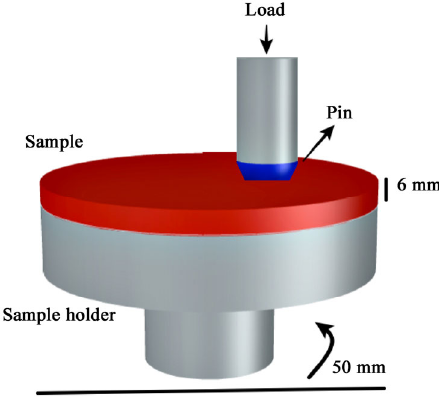
Fig. 1 Schematic diagram of the pin on disc wear